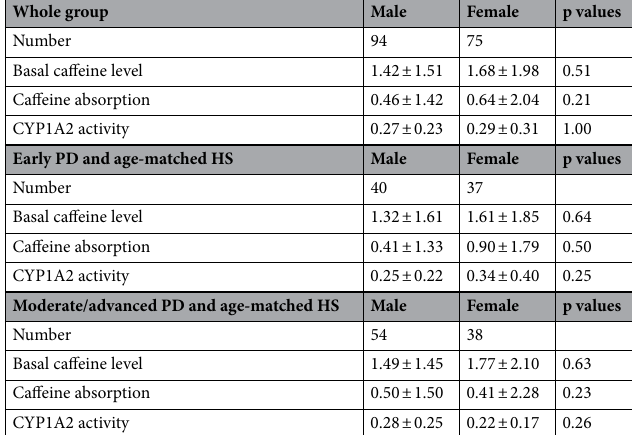
Table 2. Effect of gender on caffeine level, absorption, and metabolism.